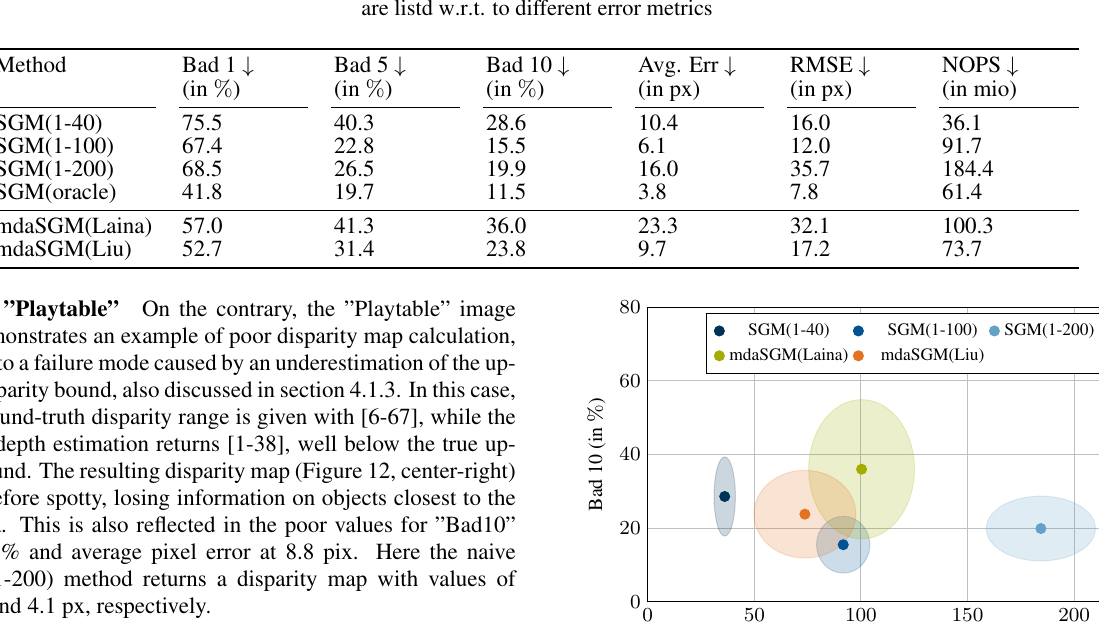
Table 1. Quantitative comparison of baseline SGM and mdaSGM applied on the Middlebury 2014 stereo benchmark. Disparity ranges for baseline methods either fixed or have access to ground truth disparity maps. mdaSGM utiziles dynamic disparity ranges. Results are listd w.r.t. to different error metrics